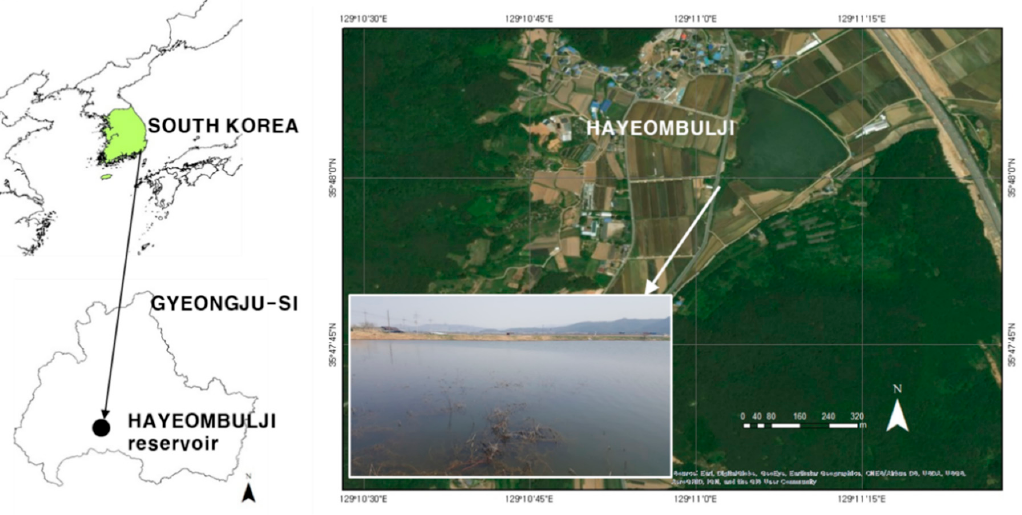
Figure 1. Study area.